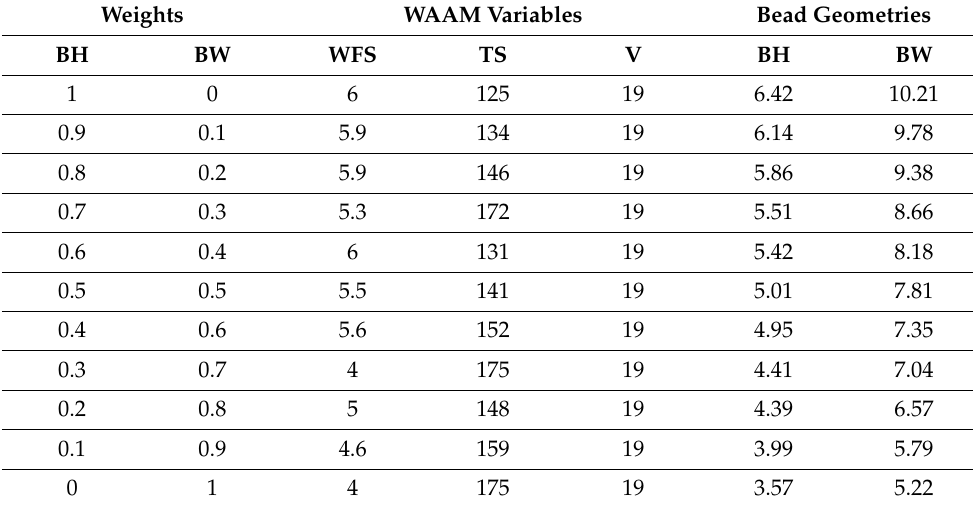
Table 7. Case study results for optimal solutions of bead